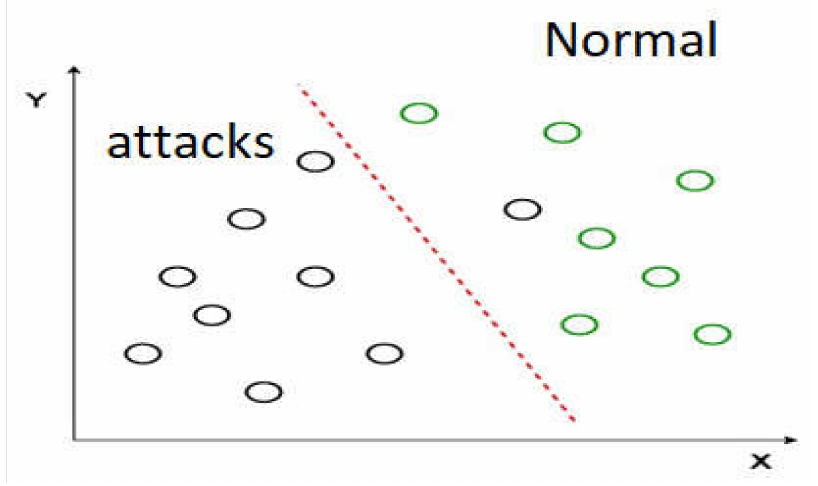
Figure 5. The linear discriminant analysis (LDA) method for analyzing